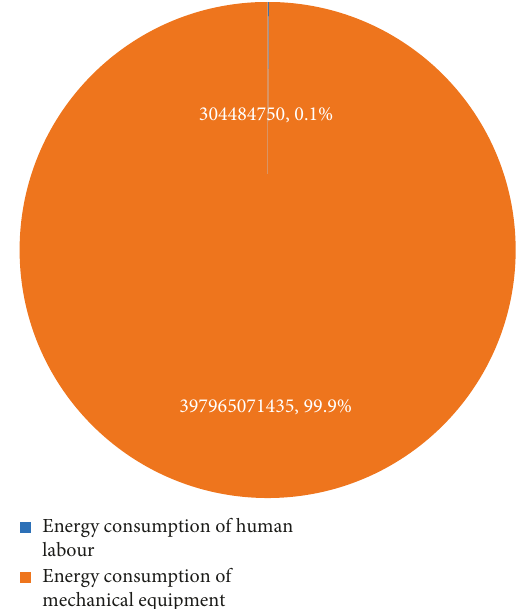
Figure 13: Energy consumption during factorized production of prefabricated columns.